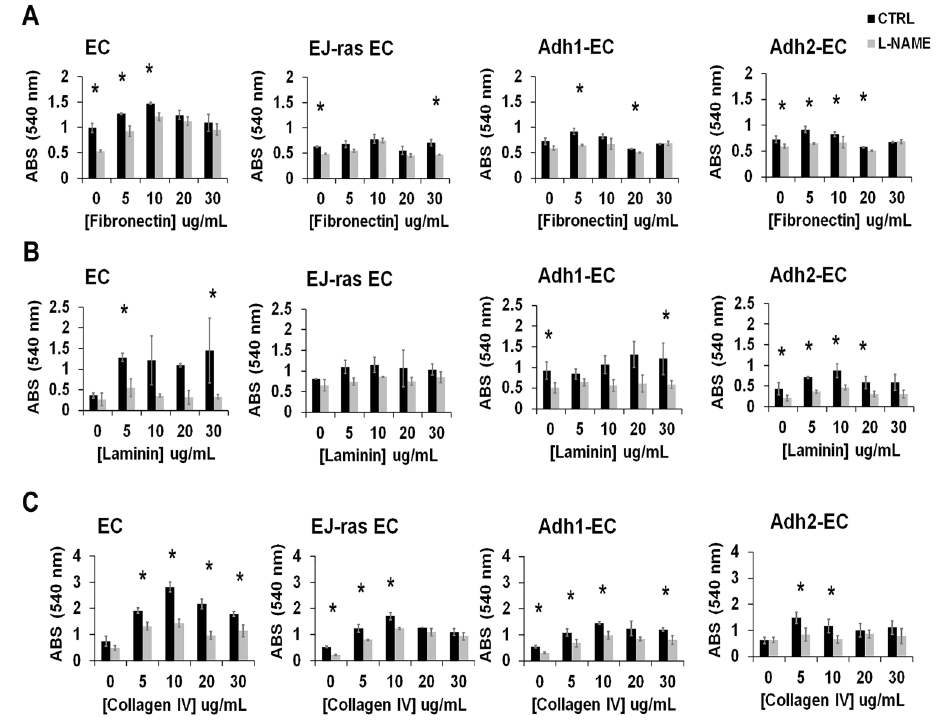
Figure 2. L-NAME treatment decreased cell adhesiveness to fi bronectin, laminin, and collagen IV in EC-derived cell lines. A , B , and C , Adhesion assays of parental (EC), EJ-ras transfected endothelial cells (EJ-ras EC), and anoikis-resistant endothelial cells (Adh1-EC and Adh2-EC) on fi bronectin, laminin, and collagen IV, respectively, after L-NAME treatment (2 mM for 1 h). The experiments were performed in triplicate for each dose and repeated three times on different days. ABS: absorbance; CTRL: Control; EC: parental endothelial cells. Data are reported as means ± SE. *P o 0.05 compared to control ( t